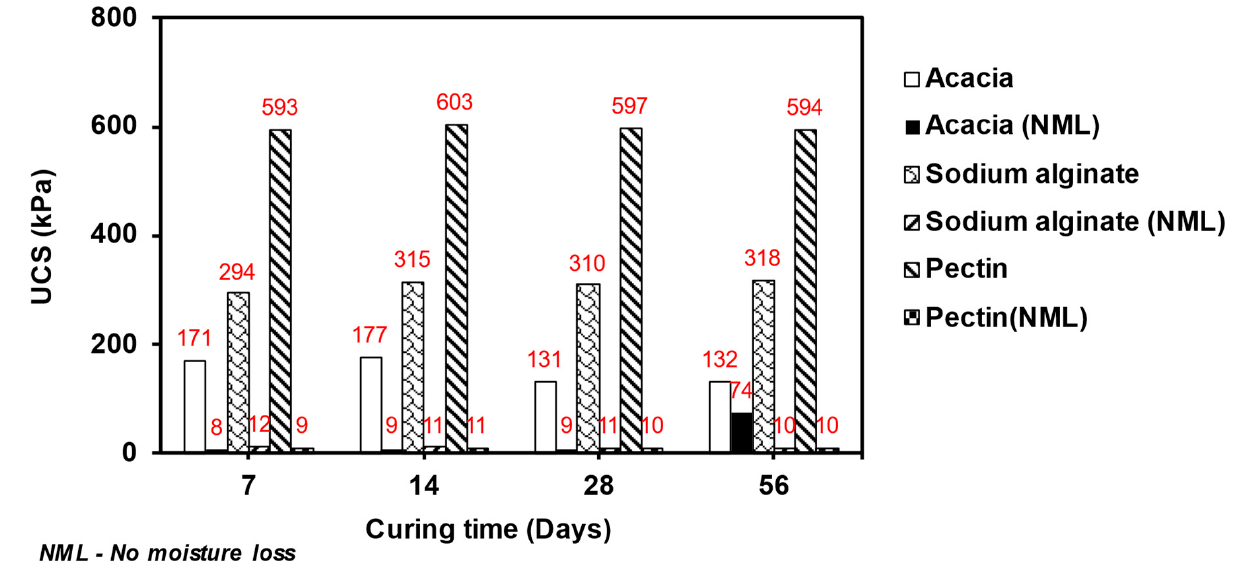
Figure 8. Effect of moisture loss on the UCS of the 2% biopolymer-modified sand .